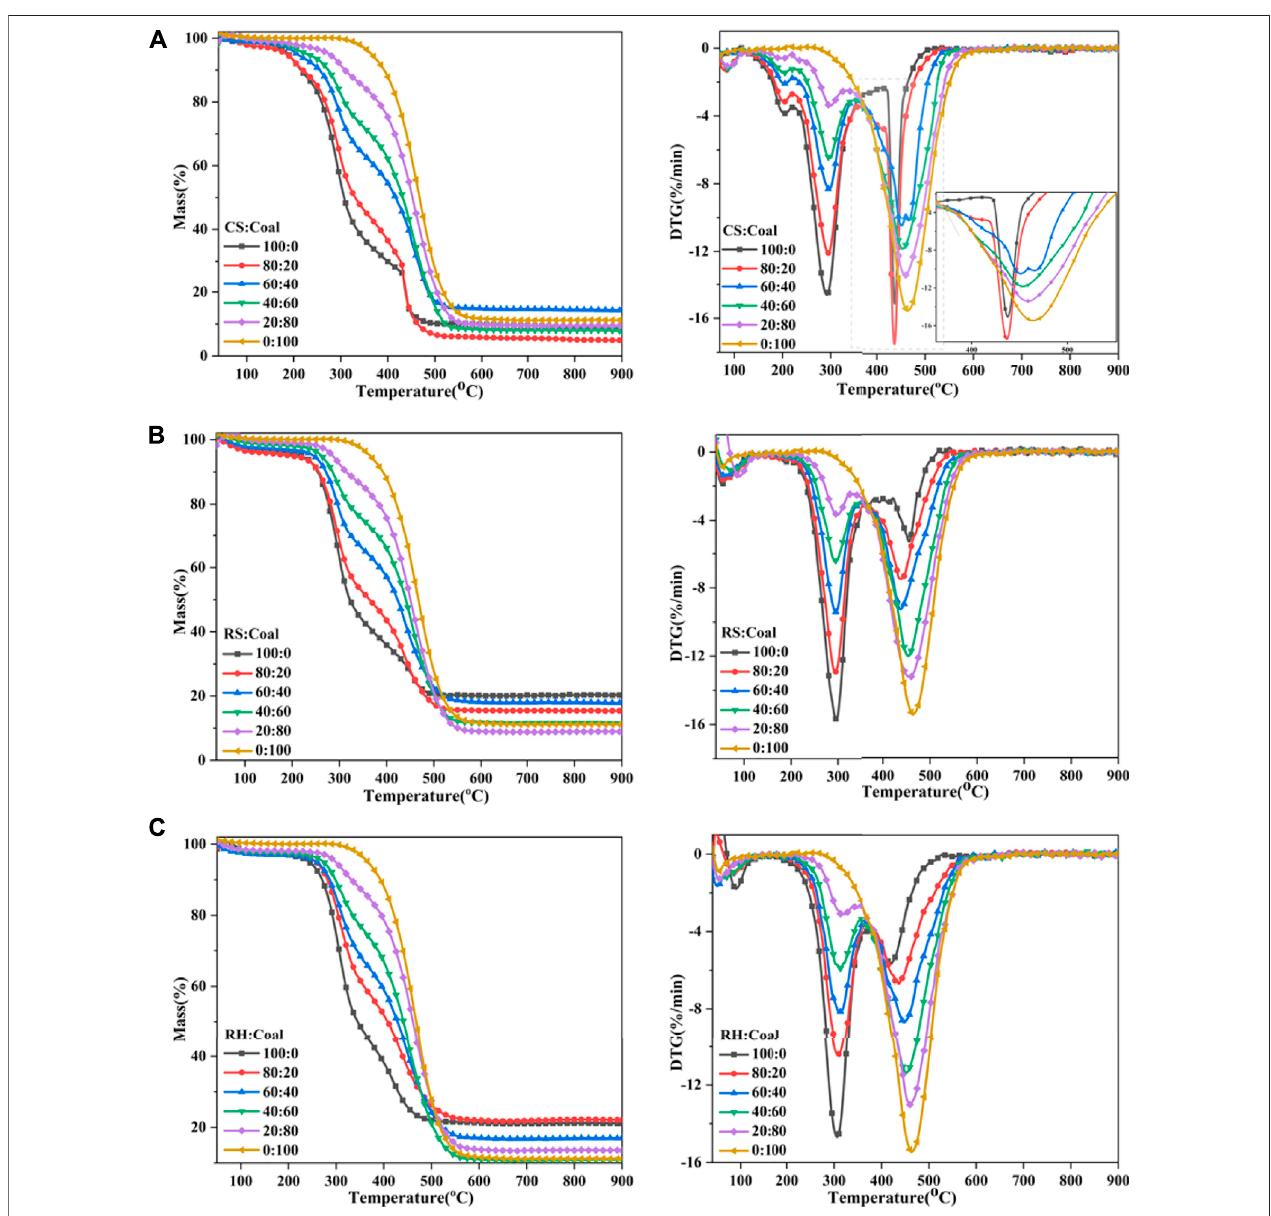
FIGURE 3 | TG and DTG curves of the blends: (A) CS, (B) RS, and (C) RH.